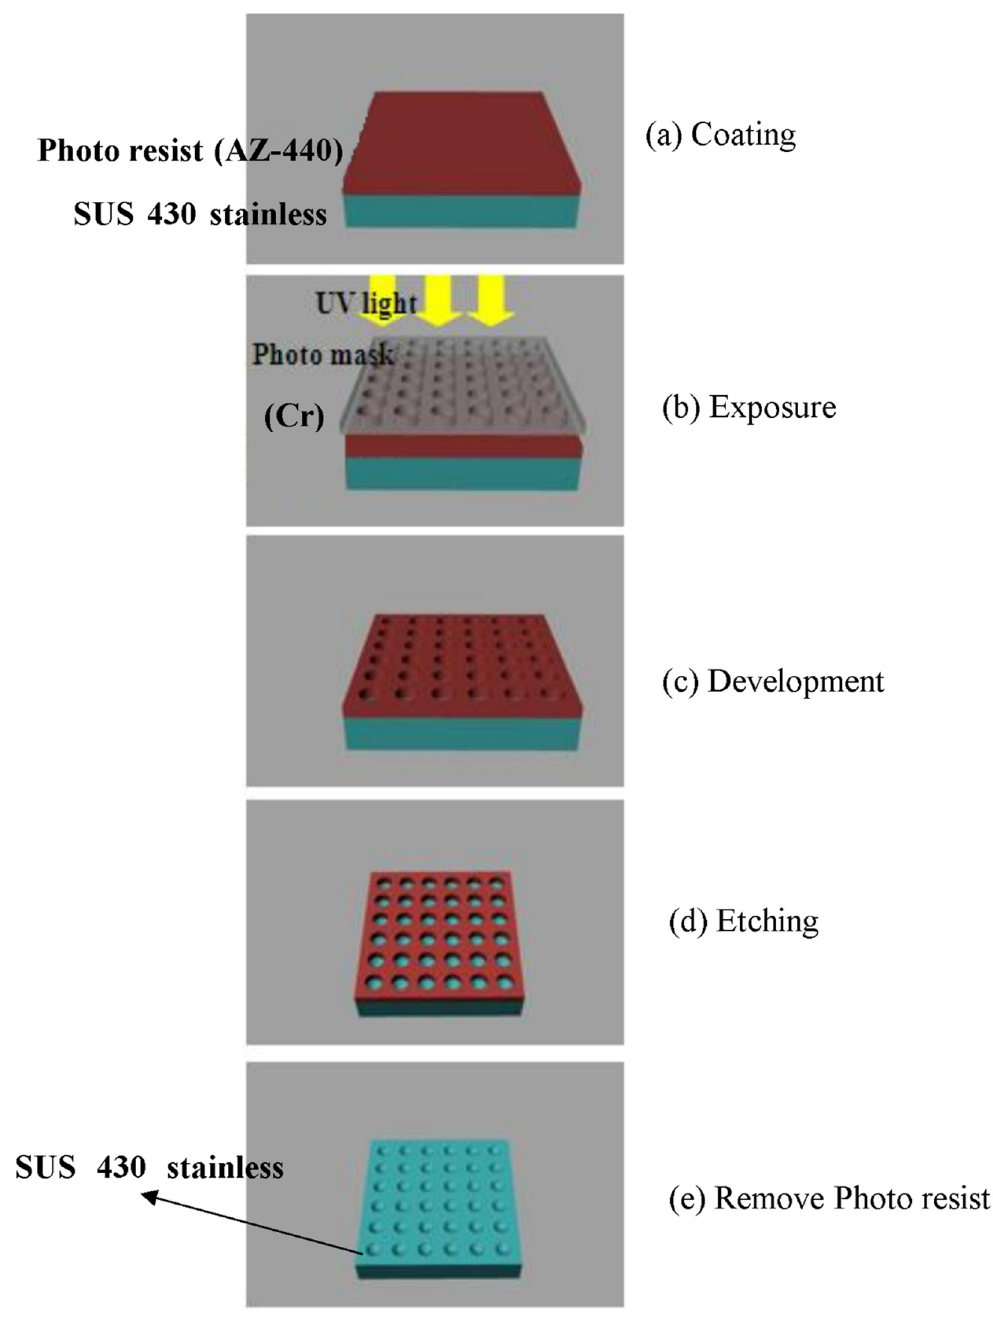
Figure 5. Processing chart for photolithography method of mold insert. Table 3. Parameters and levels selected in the main experiment of μ IM.